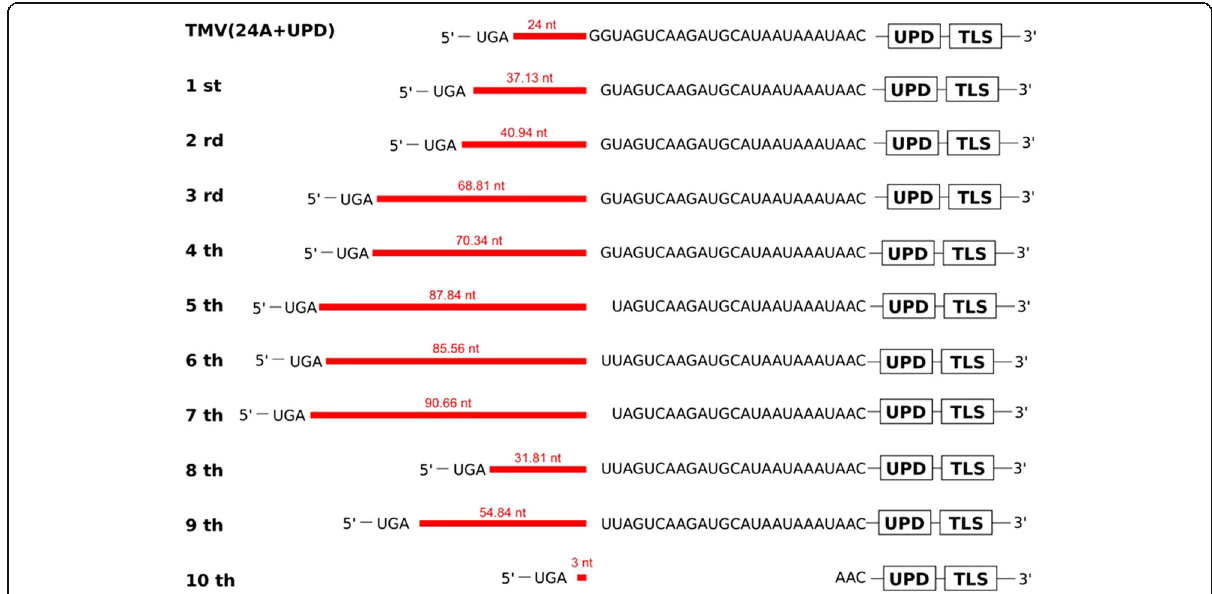
Fig. 7 The nucleotide sequence of the predominant mutant virus in each round passaging. The sequence included CP stop codon, the average length of poly(A) tract, the most occurred deletion/mutation sequence type in the non-coding sequence from the 32 clones in each round passaging, UPD and